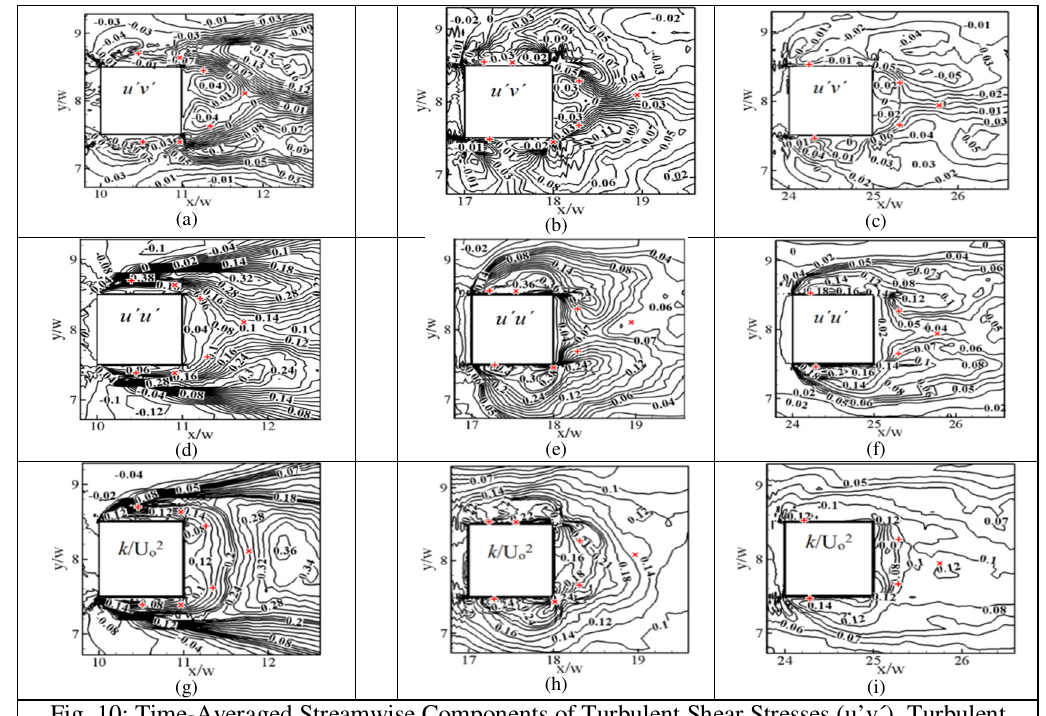
Fig. 10: Time-Averaged Streamwise Components of Turbulent Shear Stresses (u’v´), Turbulent Normal Stresses (u´u´) and Turbulent Kinetic Energy (k, normalised by U O 2 ) for Case-II-LES, (at z/w=2.0) (a-d-g) C-1, (b-e-h) C-2, (c-f-i) C-3; (Here, + represent Centre, and × represent